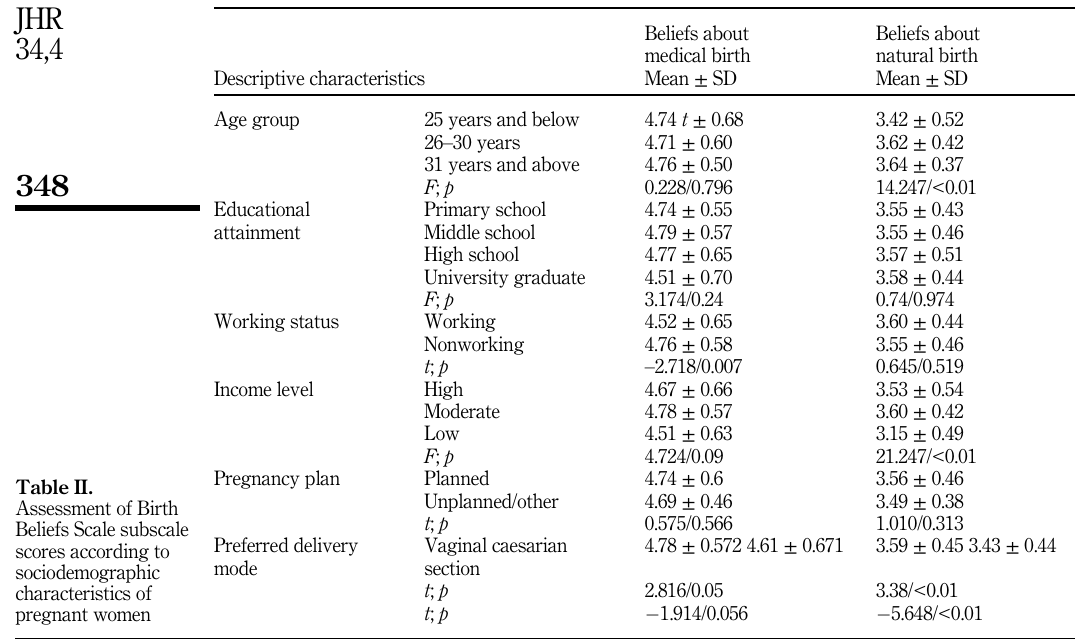
Table II. Assessment of Birth Beliefs Scale subscale scores according to sociodemographic characteristics of pregnant